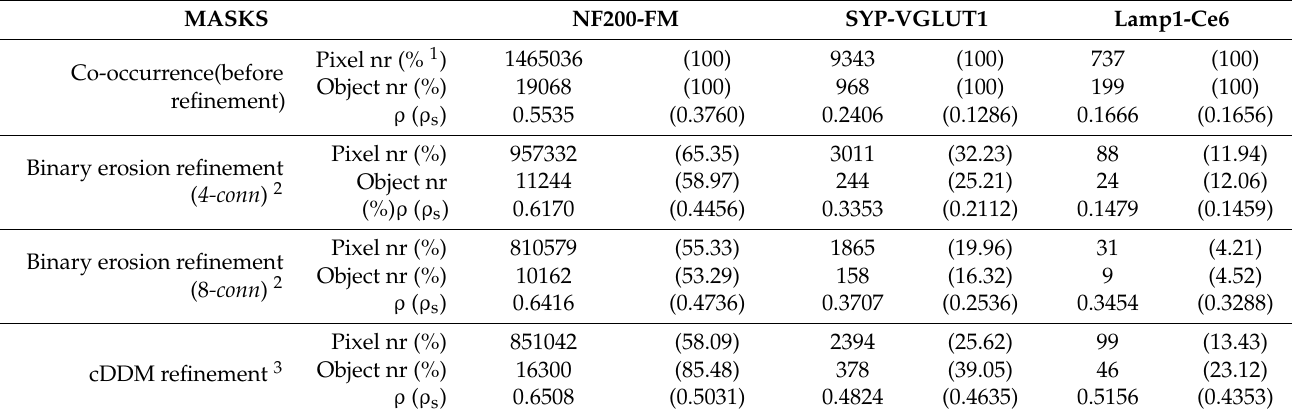
Table 1. Comparison between binary erosion and co-density analysis in refining the correlation computation domain.